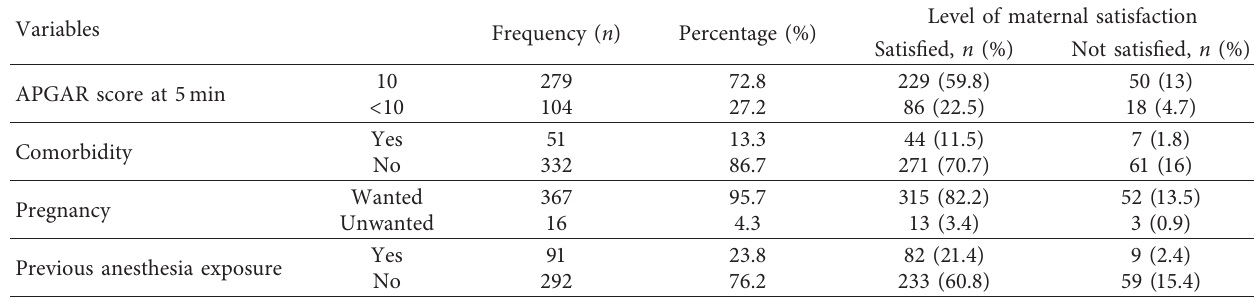
Table 2: Maternal and newborn-related factors of parturients at University of Gondar Comprehensive Specialized Hospital, Northwest Ethiopia, 2019 ( N � 383).